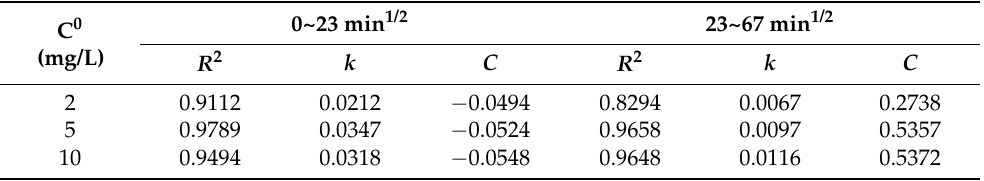
Table 7. Parameters of the Weber and Morris